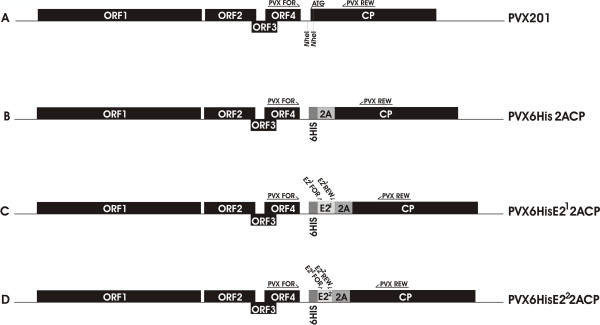
PVX-derived vectors. Schematic representation of PVX-derived vectors used. Primers are indicated in their specific annealing sites.